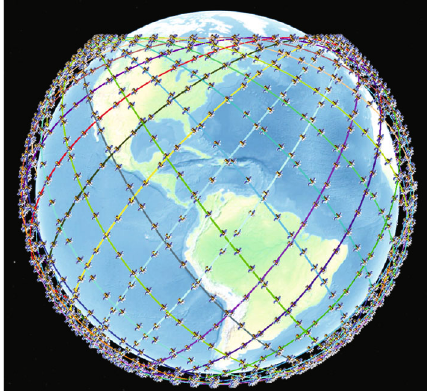
Figure 4: Huge LEO satellite constellation, Starlink, which is drawn by cesium